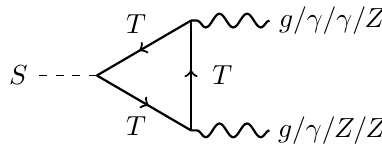
Figure 9 . The scalar S decays into gg , (cid:13)(cid:13) , (cid:13)Z and ZZ (cid:12)nal states through T loop in the zero- mixing limit (sin (cid:18) L !